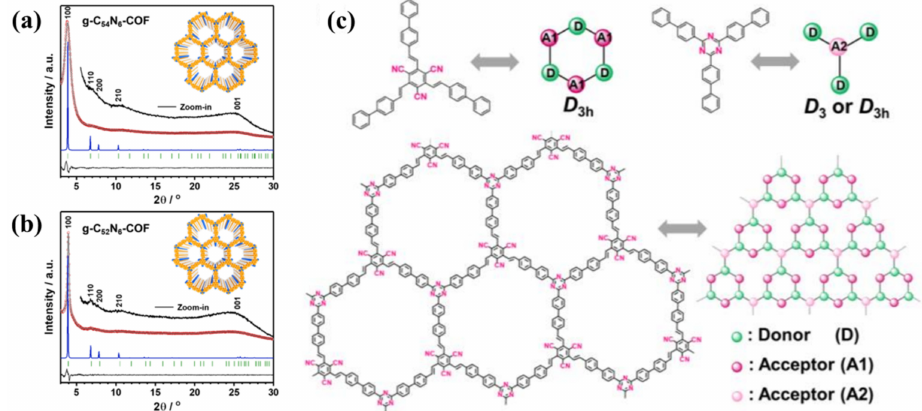
Figure 15. PXRD patterns and comparisons between ( a ) g-C 54 N 6 -COF and ( b ) g-C 52 N 6 -COF. ( c ) The octupolar structure with acceptors and donors alternating around a benzene ring or a triazine ring, respectively ( top ), and the aligned octupolar structure of g-C 54 N 6 -COF ( bottom ). Reproduced with permission from Ref. [59]. Copyright: Angewandte Chemie International Edition, 2020.